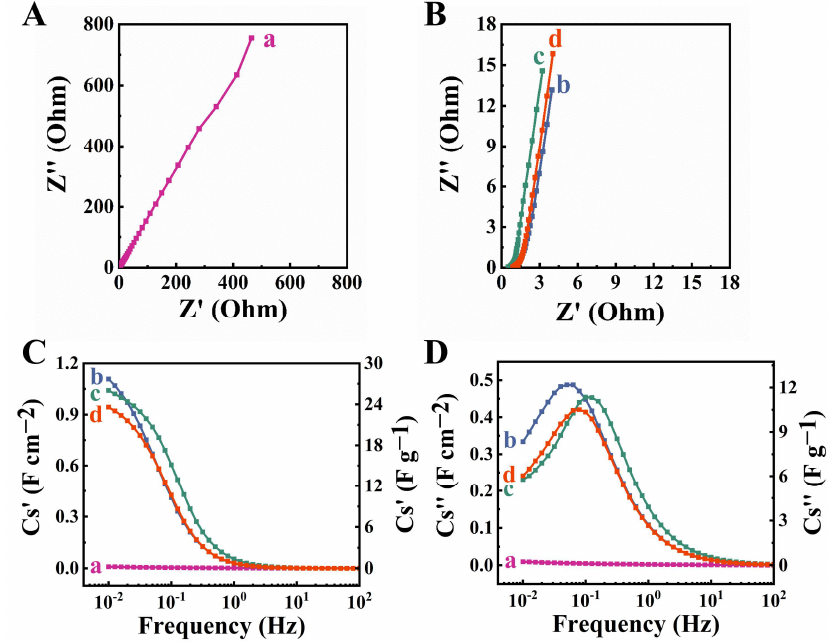
Figure 7. ( A , B ) Nyquist plots of impedance; ( C ) real and ( D ) imaginary part of complex capacitance derived from the impedance data versus frequency for (a) CFO-0, (b) CFO-10, (c) CFO-20 and (d) CFO-30